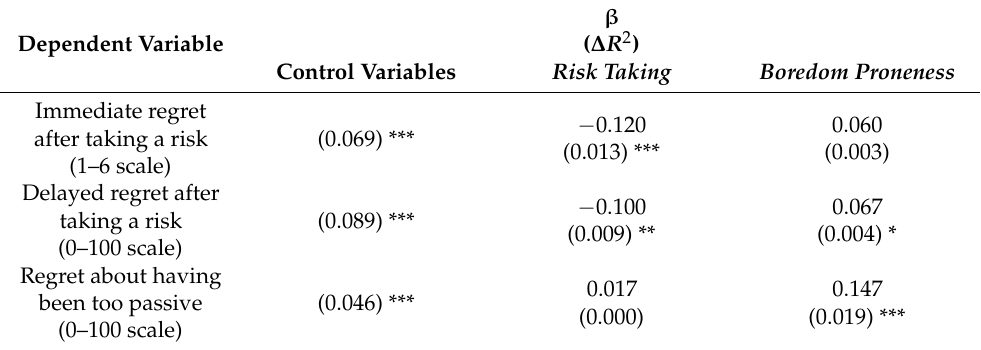
Table 2. Linear hierarchical regression models regressing sports-related risk taking on a set of control variables (group, gender, and age), risk taking, and boredom proneness. Dependent Variable